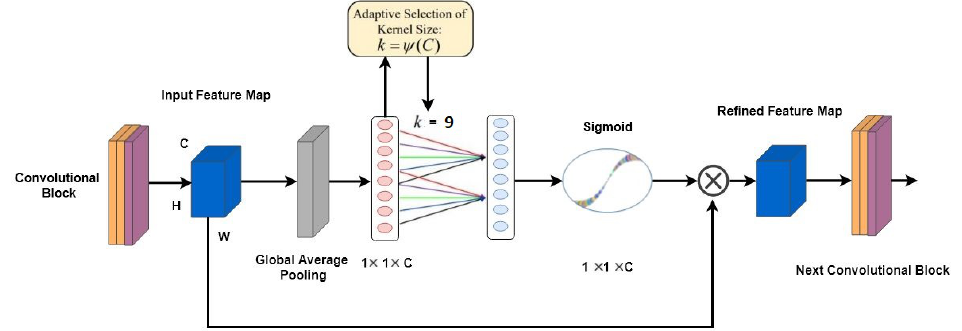
Figure 5. The ECA module takes the feature map, which is the output of a convolutional block and is 3-dimensional in shape (W × H × C). W, H, and C represent the width, height, and number of the feature map channels. The GAP reduces the dimensionality of the input feature map into 1 × 1 × C. Then the ECA module explores the local cross-channel interaction by implementing a 1 × 1 convolution via an adaptive selection of the kernel size k . After passing through the sigmoid function, the output channel weights of dimension 1 × 1 × C are used to refine the input feature map via element-wise product. Finally, the refined feature map is used as the input of the next convolutional